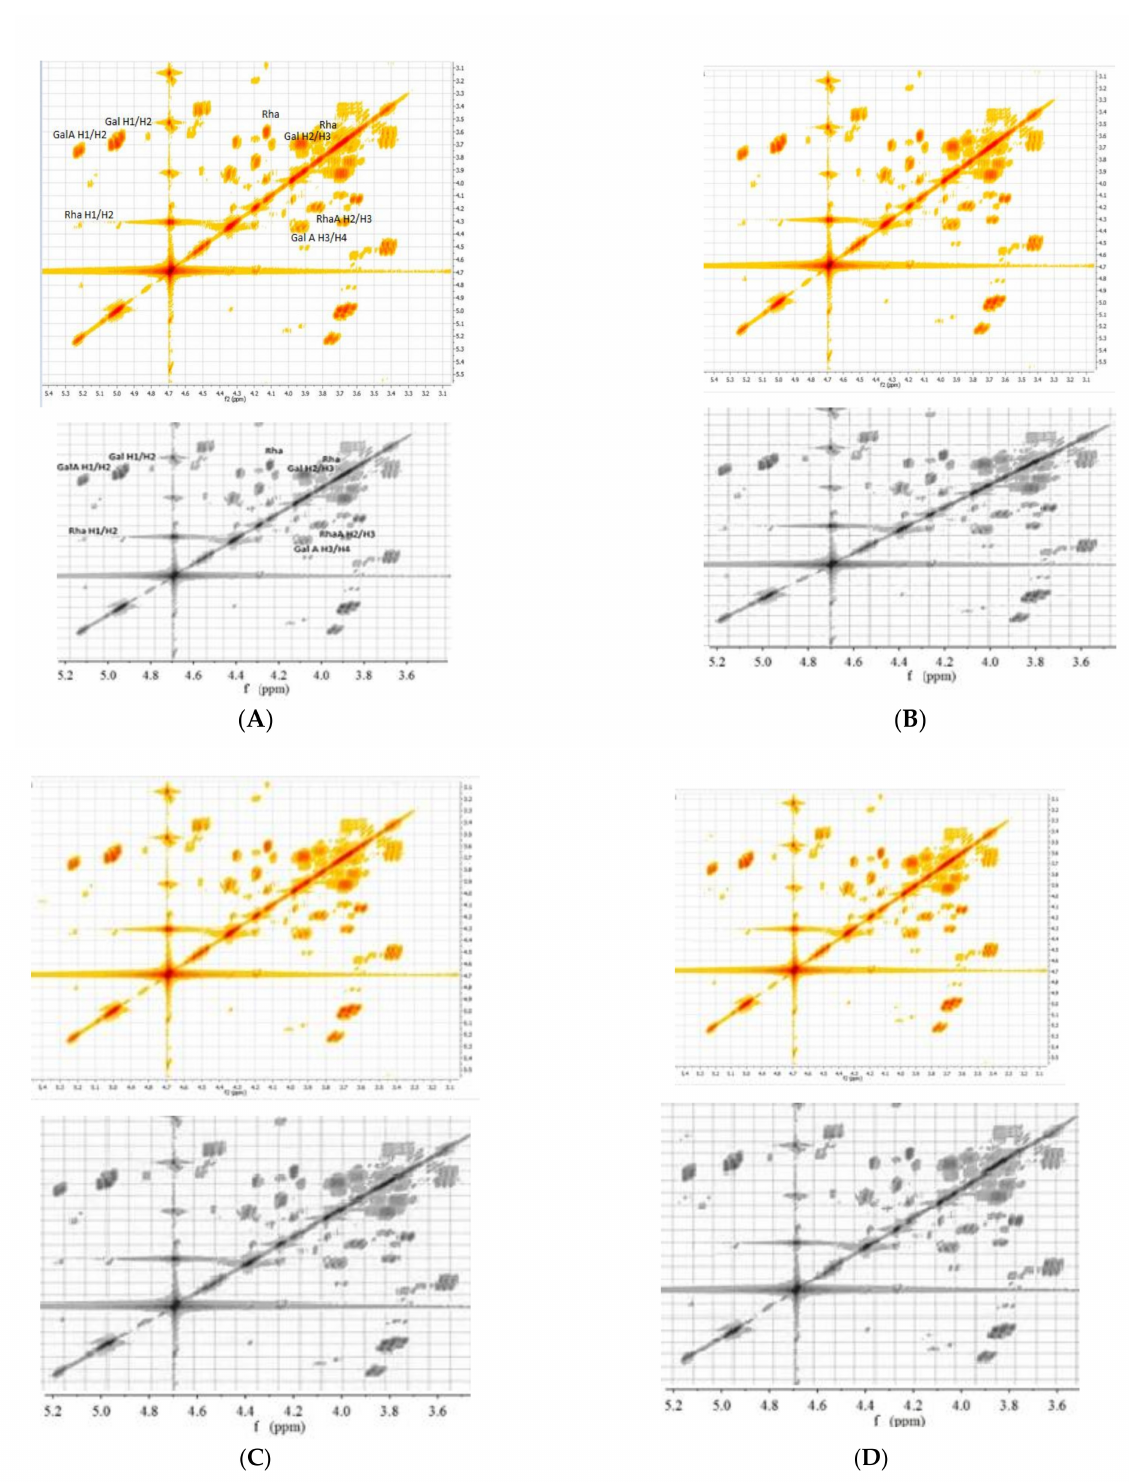
Figure 5. COSY spectra of pectin extracted from ( A ) PectaSol-C preparation, ( B ) xylanase, ( C ) cellulose, and ( D ) mixture of two